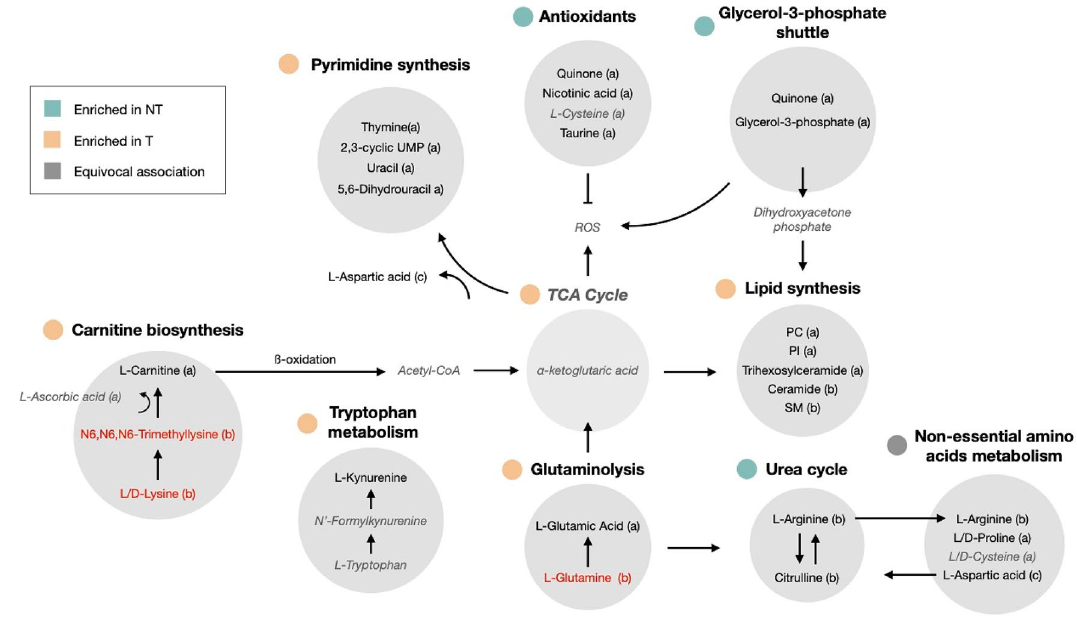
Figure 3. Schematic overview of the interactions between the identified metabolites and the involved pathways in non-transformed or transformed state. Metabolites that were discriminative for both matrices are indicated with ( a ), whereas those that were only found colon cell lines are indicated with ( b ) or tissue matrix with ( c ). Metabolites that are regulated in an opposite direction of the identified pathway are indicated in red and metabolites with conflicting changes between cell line and tissue samples or without a particular state association are written in lighter fray and italic.